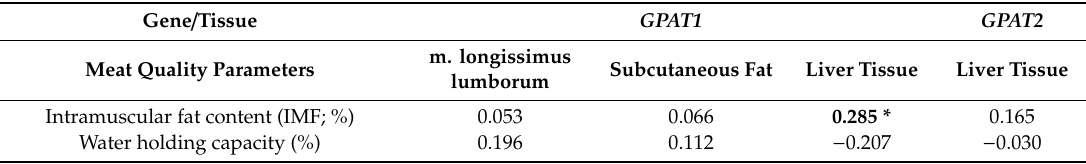
Table 4. Correlation between the expression level of the GPAT1 gene in m. longissimus lumborum, subcutaneous fat, liver tissue and the expression level of GPAT2 gene in liver tissue with meat quality parameters (* p ≤ 0.05; ** p ≤